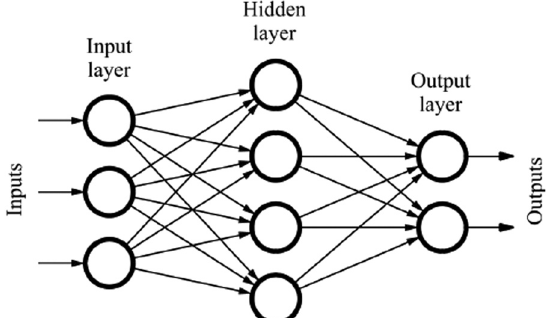
Figure 2: FFFN process fl